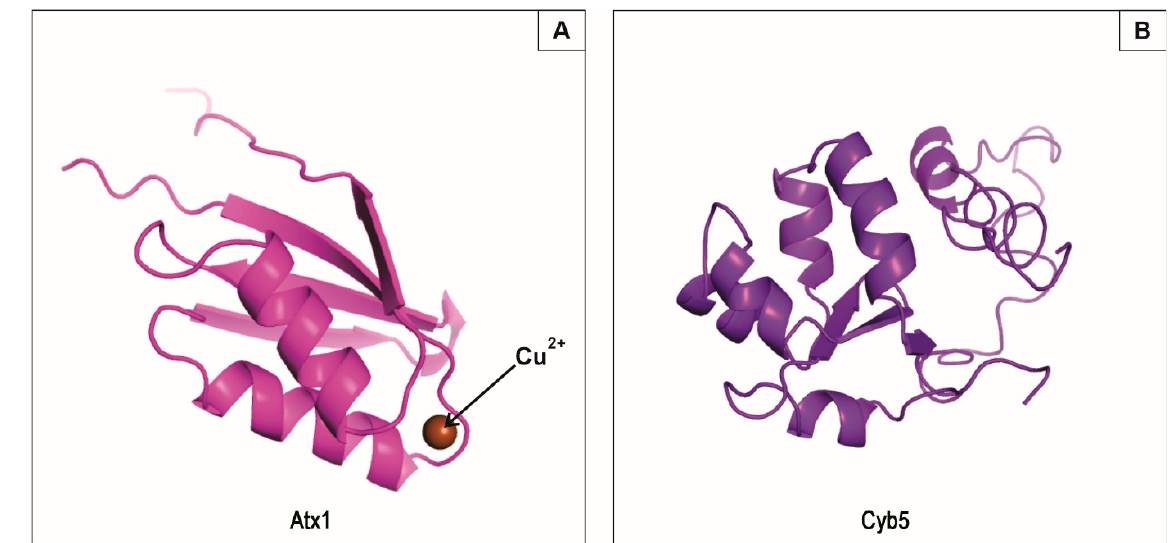
Figure 3. Molecular modeling of the P. brasiliensis proteins Pb Atx1 and Pb Cyb5. ( A )—Conformational structure of modeled Pb Atx1 showing the copper ion disposition. This conserved domain contains cysteine residues and contributes to the interaction of the protein with the copper ion. ( B )—Predicted structure for the Pb Cyb5 protein, showing in its secondary structure regions of alpha helix, beta sheet, and a terminal region rich in flexible loops.